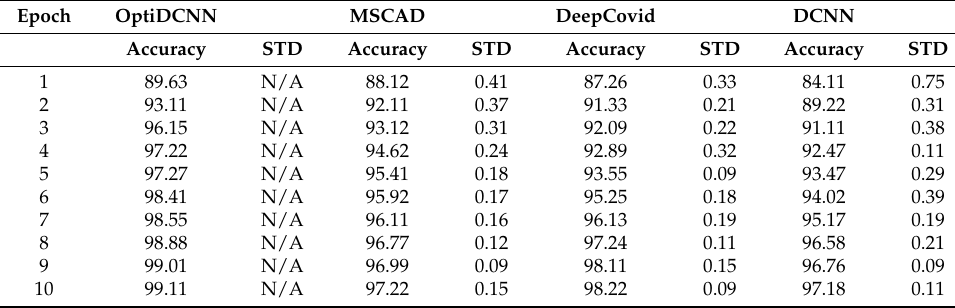
Table 5. Accuracy and standard deviation ‘STD’ for benchmark networks.